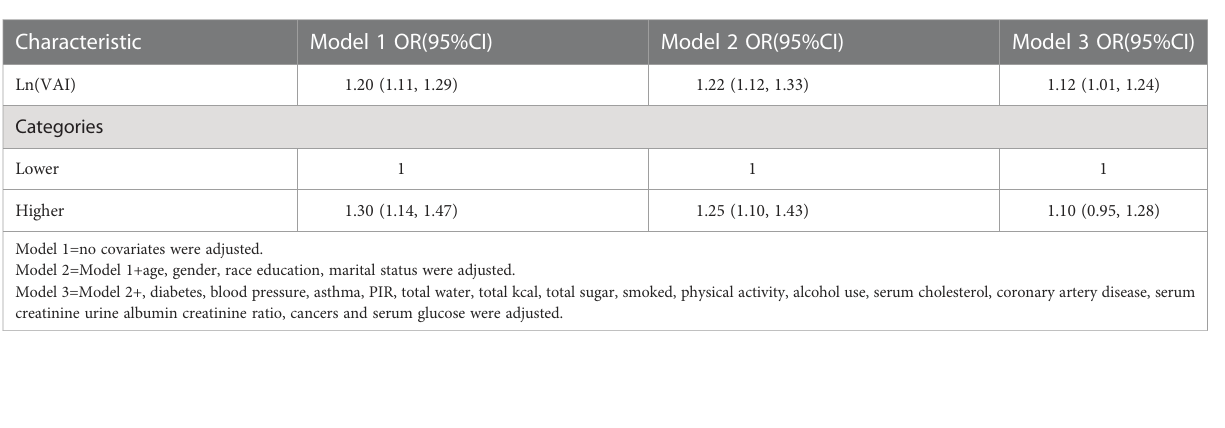
TABLE 2 Analysis between VAI with stroke